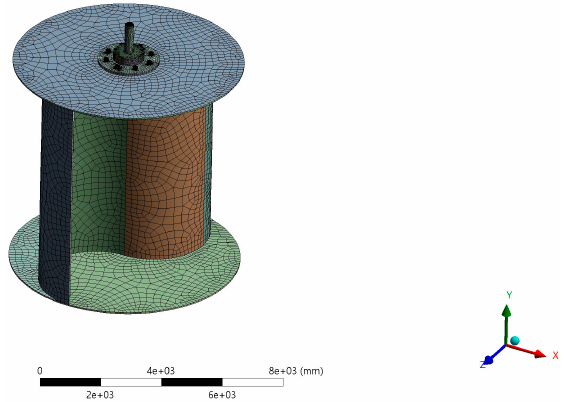
Figure 1. Mesh diagram.